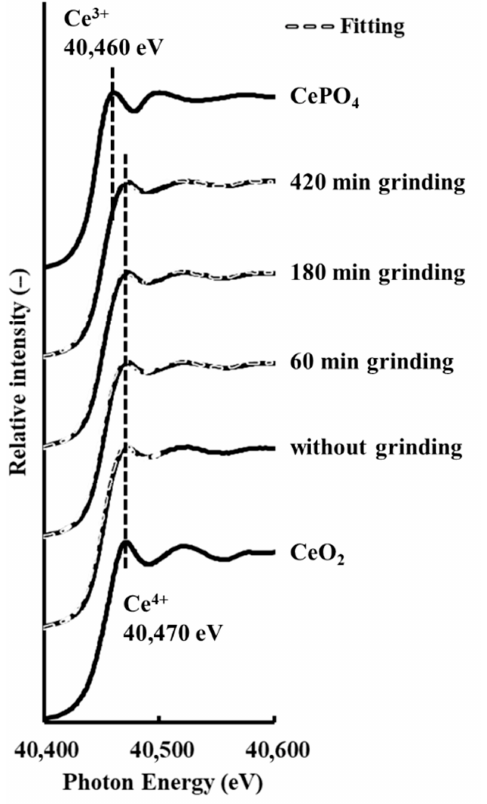
Figure 3. Cerium K-edge X-ray absorption fine structure spectra, corresponding to X-ray absorption near-edge structure analysis of the samples by grinding with microwave irradiation, showing resolved components of tri- and tetravalent cerium, based on cerium phosphate(CePO 4 ) and tetravalent cerium oxide(CeO 2 ) as reference spectra, respectively.